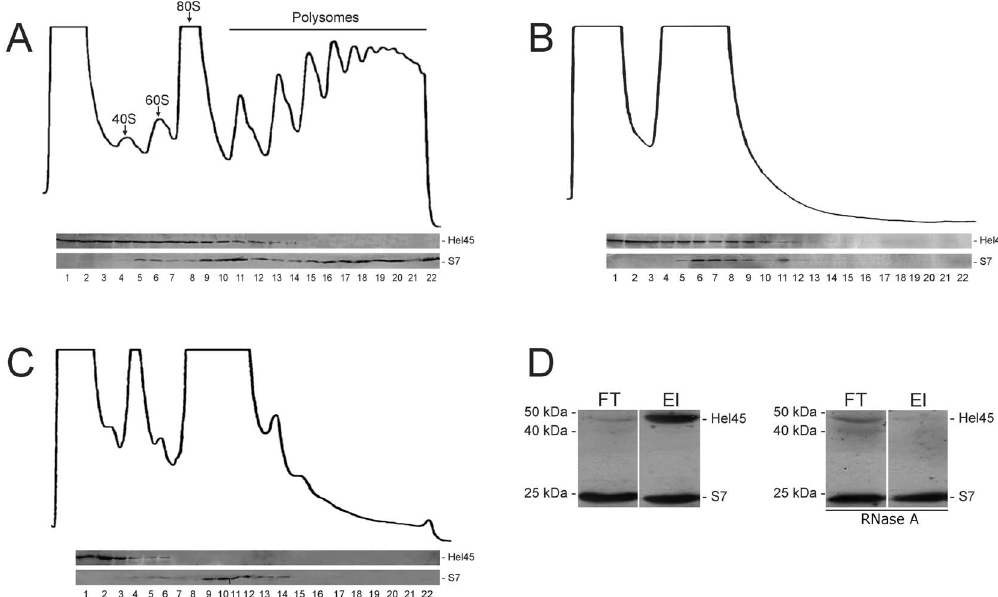
Figure 2. Hel45 is a component of ribonucleoprotein complexes in the cytoplasm. Polysome fractionation by sucrose density gradient. The fractions (1–22) were collected after the sedimentation of cytoplasmic extract from T. cruzi treated with 100 m g/ml cycloheximide (A), 2 mM puromycin (B), or 500 U/ml micrococcal nuclease in the presence of 2 mM CaCl 2 (C). The 40S and 60S ribosomal subunits, the 80S ribosome monomer and polysomes are indicated. A western blot was performed with an anti-Hel45 antibody for each fraction. S7, a small ribosomal subunit protein, was used as a control. (D) mRNP isolation assay. Western-blot analysis with anti-Hel45 and anti-S7 antibodies and mRNPs obtained from the T. cruzi cytoplasmic fraction after elution from oligo(dT)-conjugated magnetic beads (El). As a control, cytoplasmic extract was treated with 10 m g/ml RNaseA before mRNP capture. FT=flow-through from cytoplasmic extract not bound to the oligo(dT). El=eluted fraction.